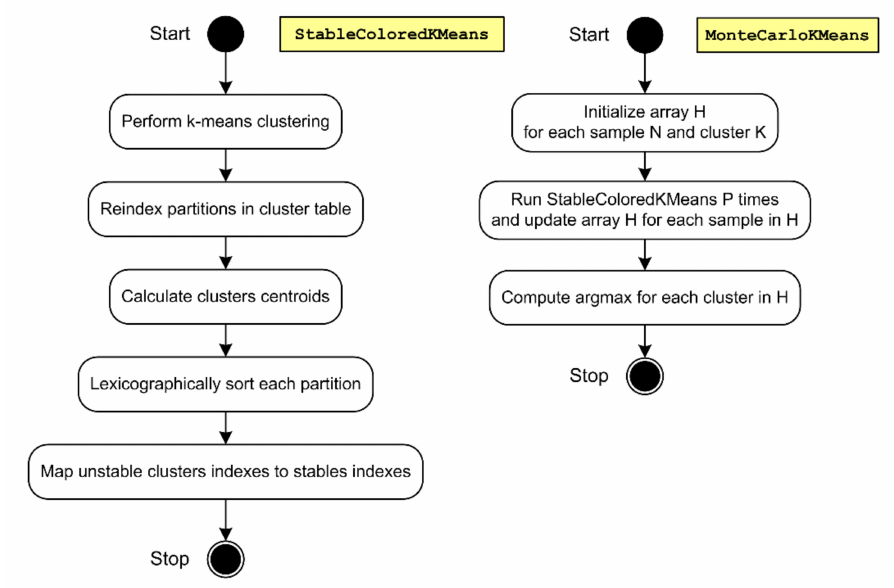
Figure A2. The clustering procedure using Monte-Carlo simulation stabilized k-means implemented in the Python software tool. UML activity diagrams illustrating functions StableColoredKMeans ( left ) and MonteCarloKMeans ( right